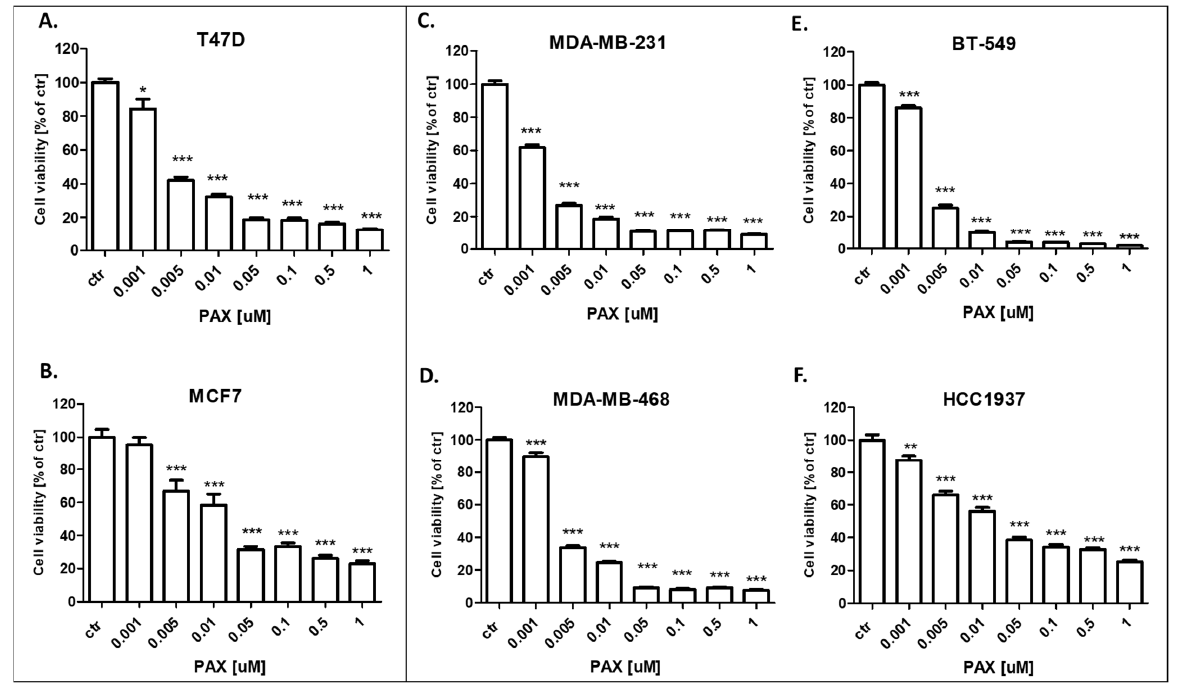
Figure 5. Effect of paclitaxel (PAX) on the viability of the ( A ) T47D, ( B ) MCF7, ( C ) MDA-MB-231, ( D ) MDA-MB-468, ( E ) BT-549 and ( F ) HCC1937 BC cells after 96 h with 0.001–1 µM of the drug in the MTT assay. The data are presented as the means ± standard deviation (±SD); one-way ANOVA, Tukey’s post-hoc testing; * p < 0.05, ** p < 0.01, *** p < 0.001.